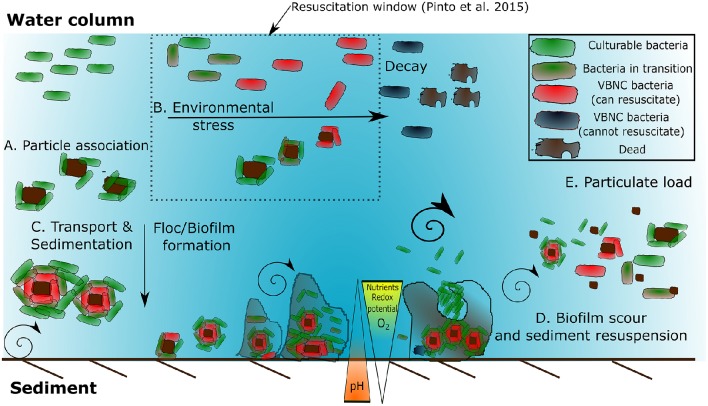
Factors stimulating bacterial accumulation in the environment, induction to and resuscitation from VBNC state. (A) Bacterial-particle association and bacteria-bacteria association. (B) Environmental stressors such as high/low nutrients, oxygen, redox potential, and oxidative stress induce biofilm formation. (C) Transport and sedimentation provides a downward flux to sediment. As the biofilm grows on the sediment the mass transfer rate is no longer sufficient resulting in localized gradients in electron acceptors and nutrients. This results the induction of VBNC bacteria. (D) High flow events result in shear and can slough the biofilm, reducing the stabilizing effect of the EPS. (E). This can further exacerbate the resuspension of bacteria within the water column leading to increased particulate load (Adapted from Ayrapetyan et al., 2014b; Pinto et al., 2015).